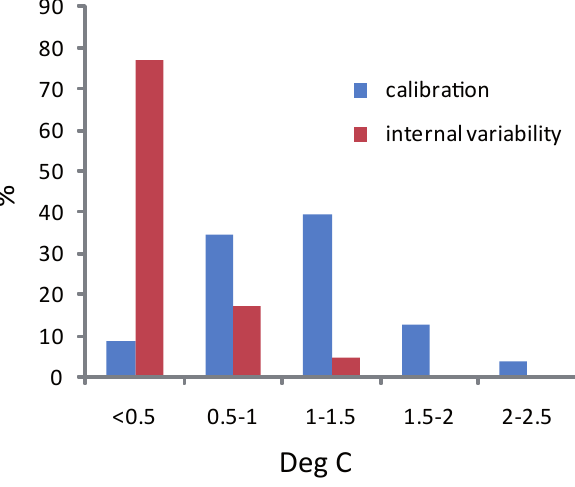
Fig. 6. The frequency distribution of calibration ( σ c ) vs. internal variability uncertainty ( σ v ) in the